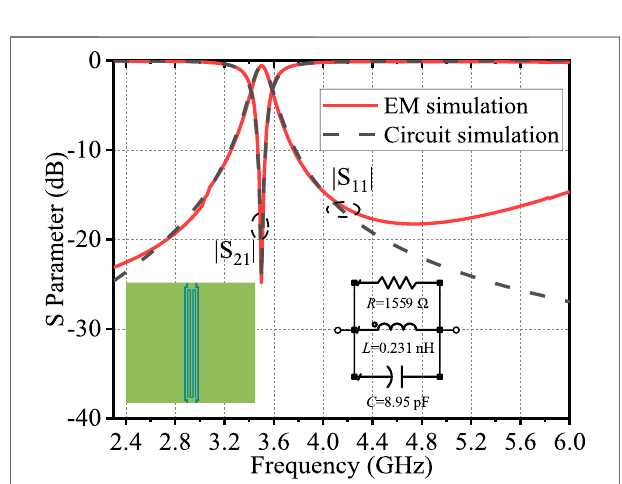
FIGURE 5 | EM and circuit simulation results of the proposed GCPW DMS